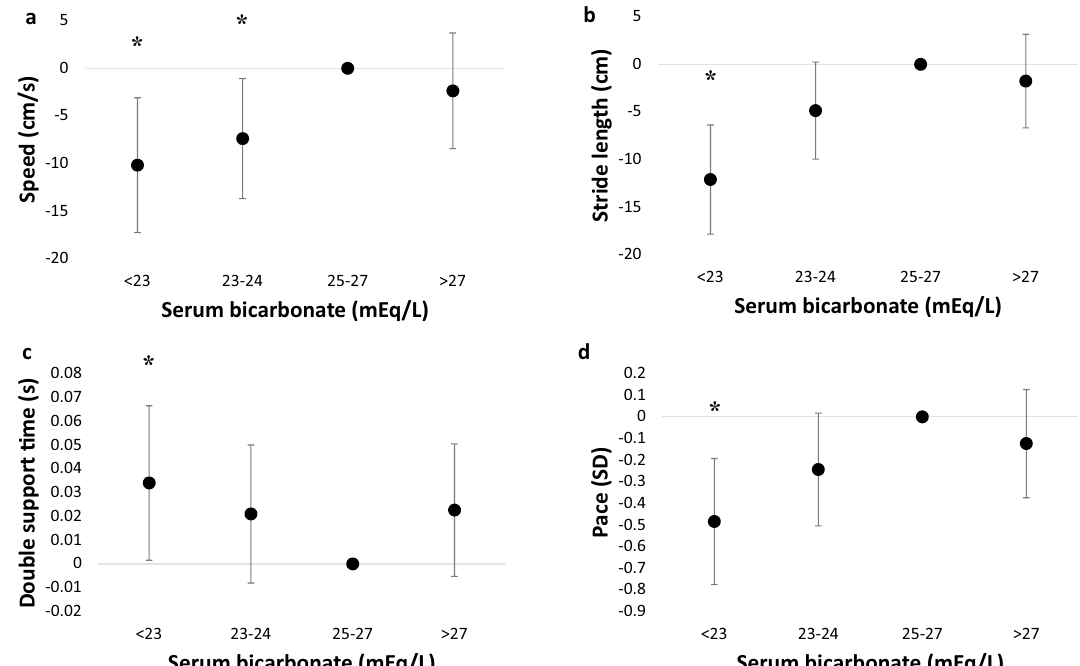
Figure 2. Lower serum bicarbonate is associated with progressively greater gait disturbances. Multivariable linear regression was performed on ( a ) gait speed, ( b ) stride length, ( c ) double support time, and ( d ) pace. The reference group was serum bicarbonate 25–27 mEq/L (middle tertile). Models were adjusted for age, sex, race, education, smoking status, body mass index (BMI), number of comorbidities, number of medications, diuretic use, diagnosis of neuropathy, cardiovascular disease, hypertension, diabetes, emphysema or chronic obstructive pulmonary disease (COPD), blood urea nitrogen (BUN), and estimated glomerular filtration rate (eGFR). Error bars denote 95% confidence intervals. Asterisks denote P < 0.05. Serum bicarbonate < 23 mEq/L (n = 46), 23–24 mEq/L (n = 66), 25–27 mEq/L (n = 144), > 27 mEq/L (n = 67). SD standard deviation. N = 323